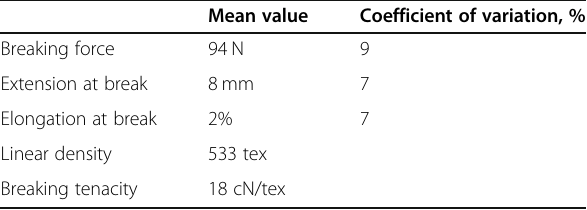
Table 1 Basic properties of hybrid carbon-copper braid Mean value Coefficient of variation,